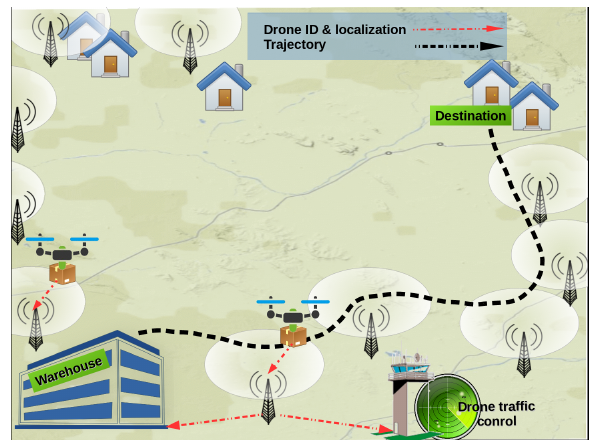
Figure 1. Drone package